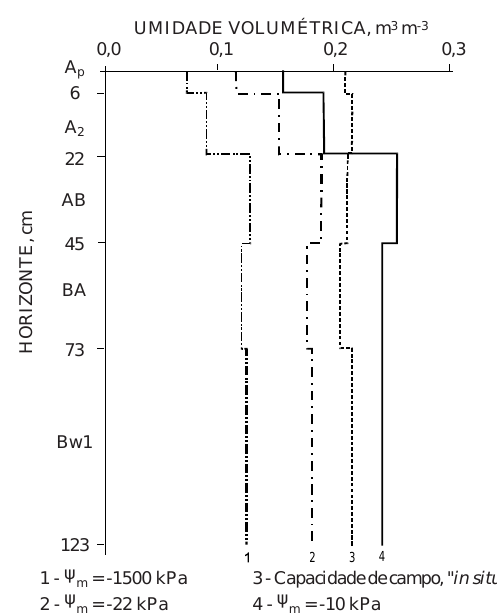
Figura 2. Perfil de umidade do solo após aplicação dos potenciais matriciais indicados (amostras de solo deformadas - curvas 1,2 e 4) e umidade do solo na capacidade de campo determinada “ in situ